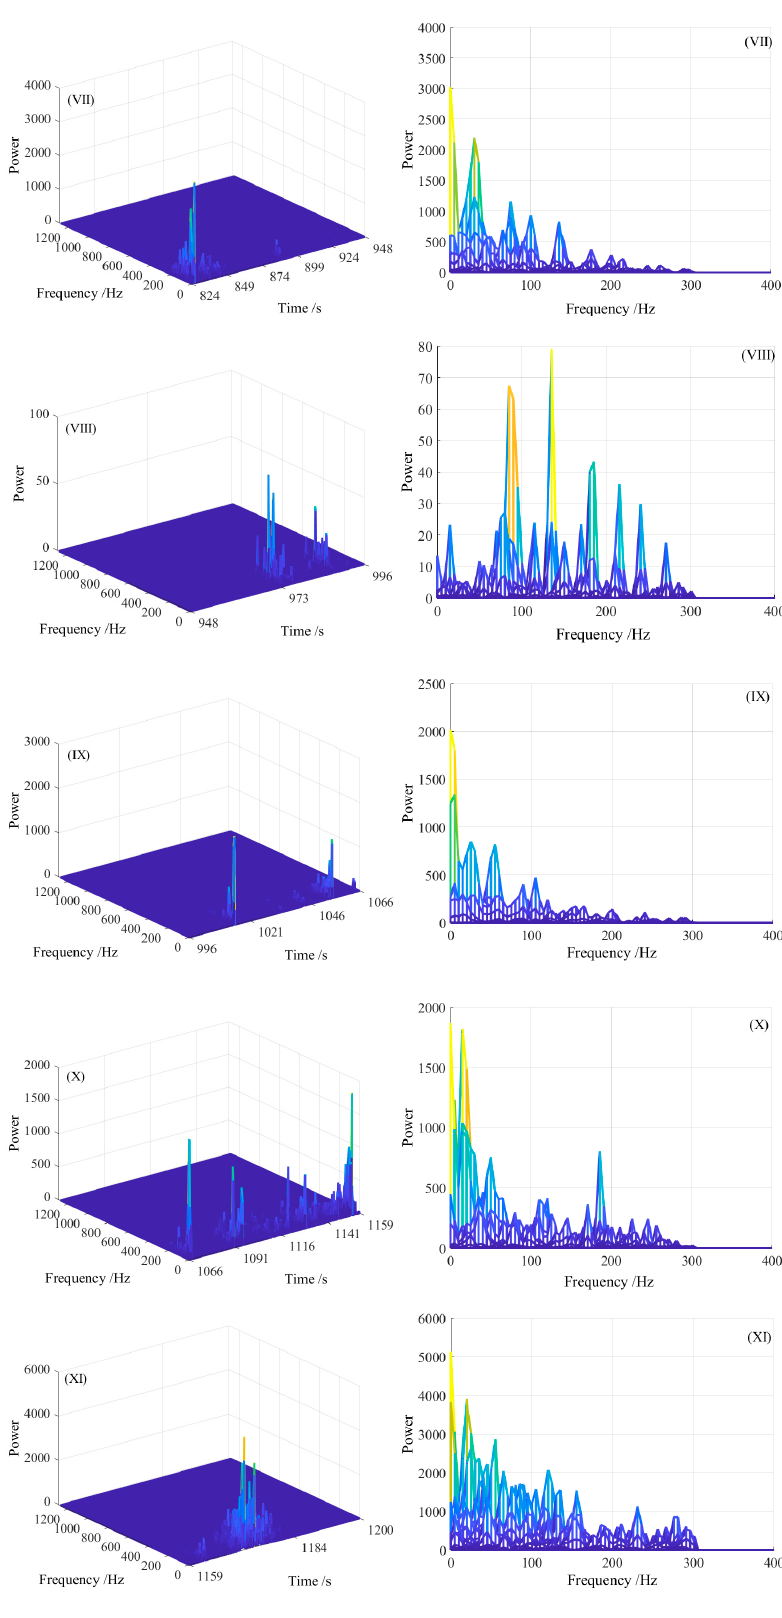
Figure 13. Hilbert power spectrum of the low-frequency component of MS at loading stages I–XI in Exp. Y1. Note: the left part is the Hilbert power spectrum, and the right part is the power-frequency diagram. The power in the Figure 13 is dimensionless, which represents the possibility of the signal in a specific time and frequency.